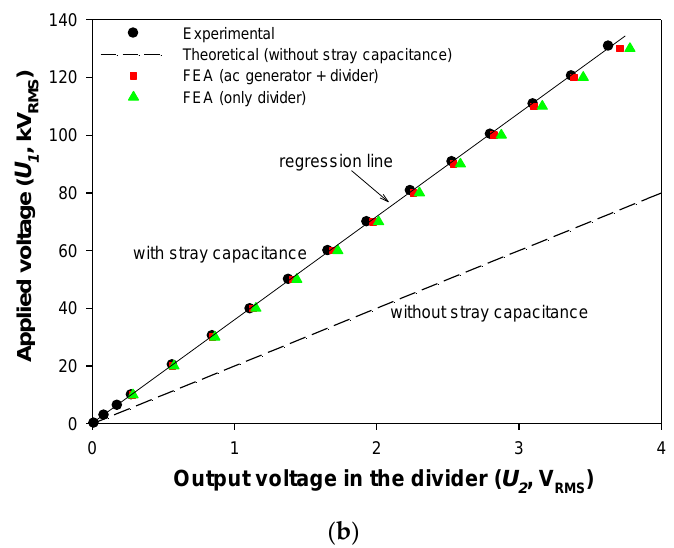
Figure 6. Behavior of the resistive divider under power frequency AC supply (50 Hz). ( a ) Layout showing the divider and the AC generator (not in scale), ( b ) Experimental points and finite element analysis (FEA) simulations considering the AC generator (it results in C g = 47.07 pF, k = 0.16) and without the generator (only the divider, C g = 12.98 pF, k = 0.58).